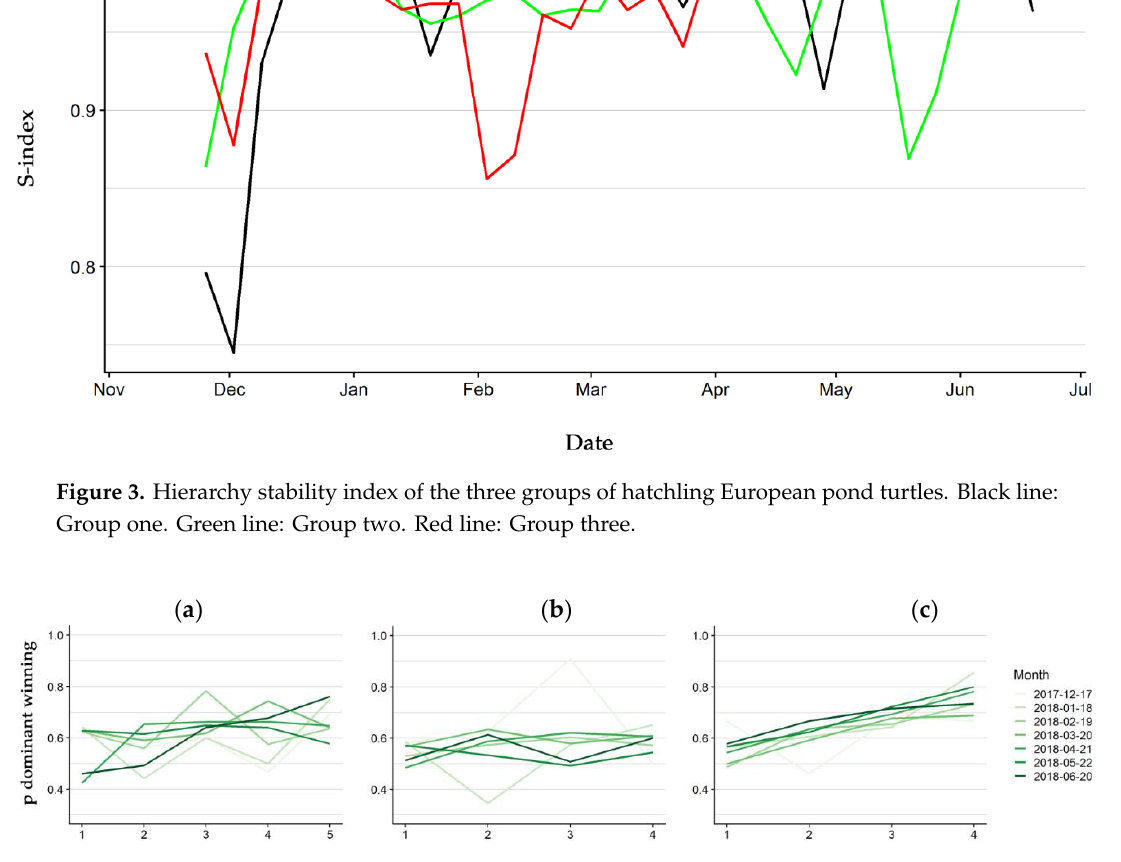
Figure 4. Hierarchy steepness variation in time. Monthly probability of the dominant winning ( y axis) a dyadic interaction in the function of the difference in rank to the submitted individual participating in the interaction for Group one ( a ), two ( b ) and three ( c ). One line for each month was fitted and it was plotted with increasing green intensity.